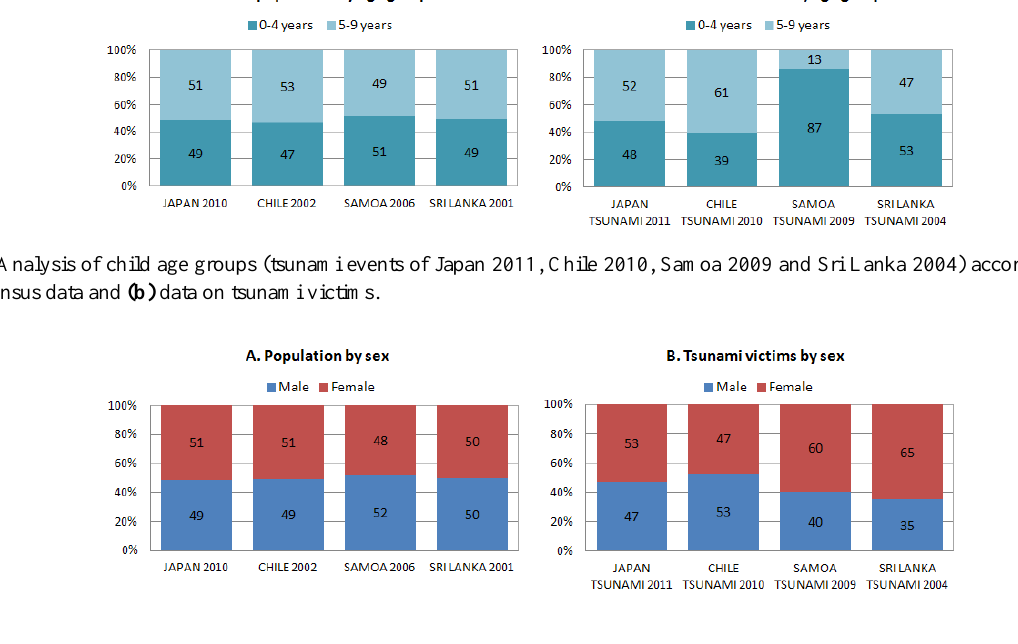
Figure 5. Gender analysis (tsunami events of Japan 2011, Chile 2010, Samoa 2009 and Sri Lanka 2004) according to (a) pre-tsunami census data and (b) data on tsunami